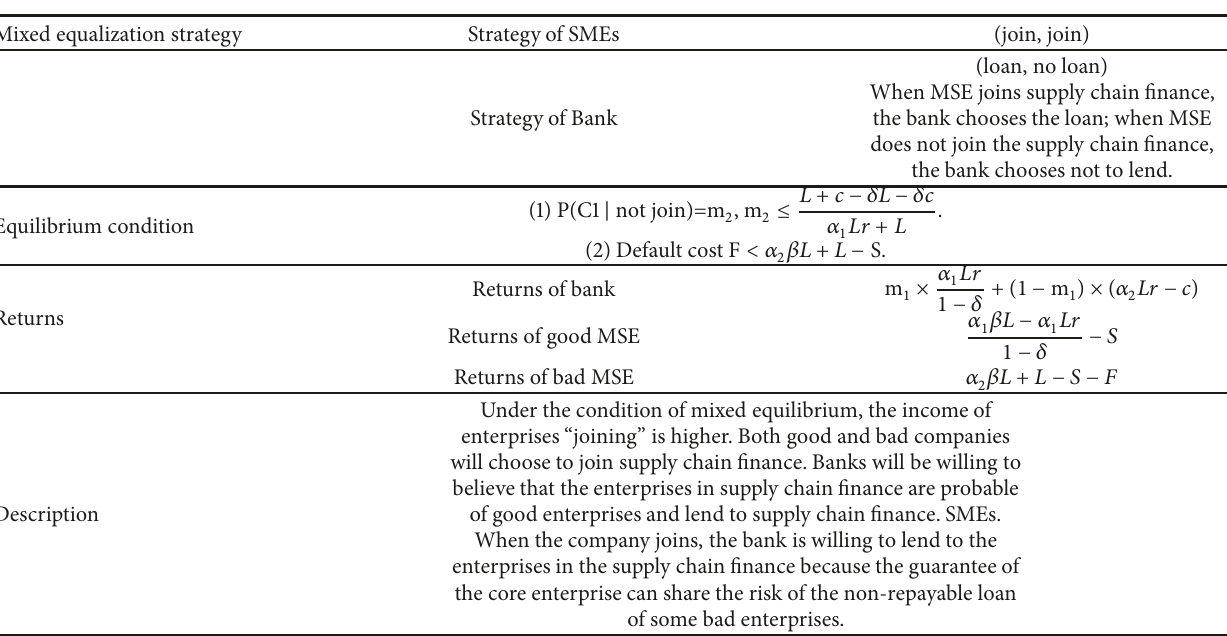
Table 2: Summary of mixed